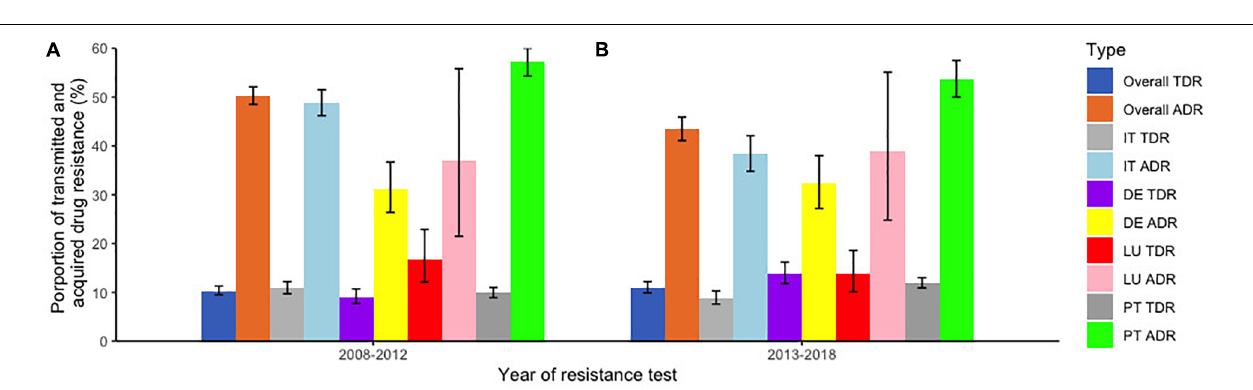
FIGURE 3 | Proportion of transmitted and acquired drug resistance per country of follow-up in two different time periods. (A) Between 2008 and 2012; (B) between 2013 and 2018. TDR, Transmitted drug resistance; ADR, Acquired drug resistance; IT, Italy; DE, Germany; LU, Luxembourg; PT, Portugal.